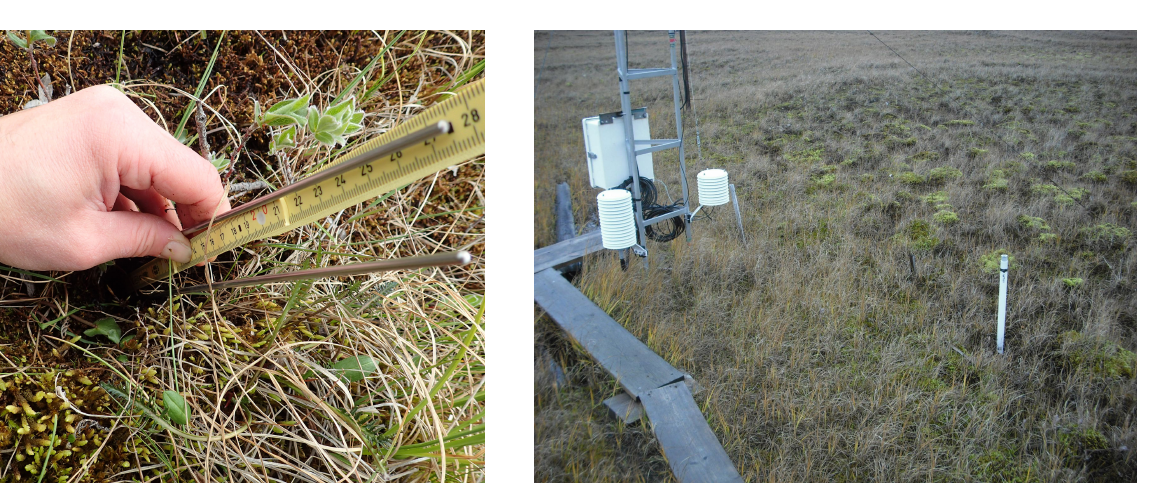
Figure D3. Installation for water-level measurements using a per- meable ground water measurement tube with a Schlumberger Mini-